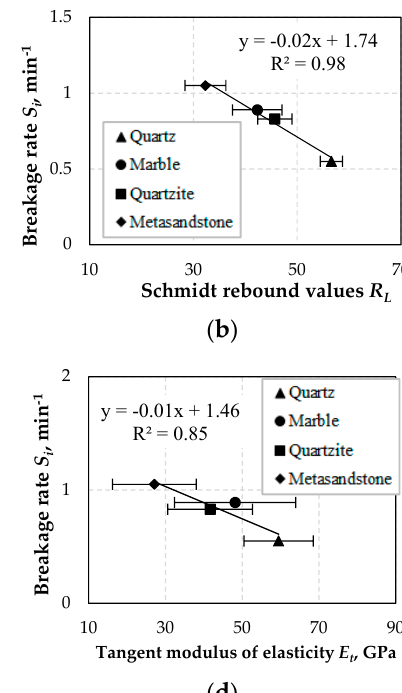
y = -0.15x + 1.90 R² = 0.88